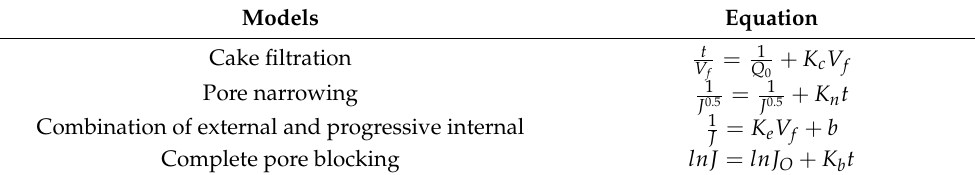
Table 4. Equations of the four classic filtration models.